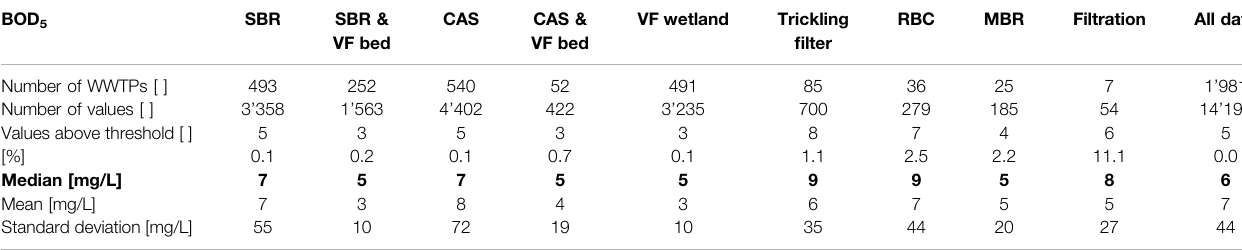
Bold values indicate the median values.